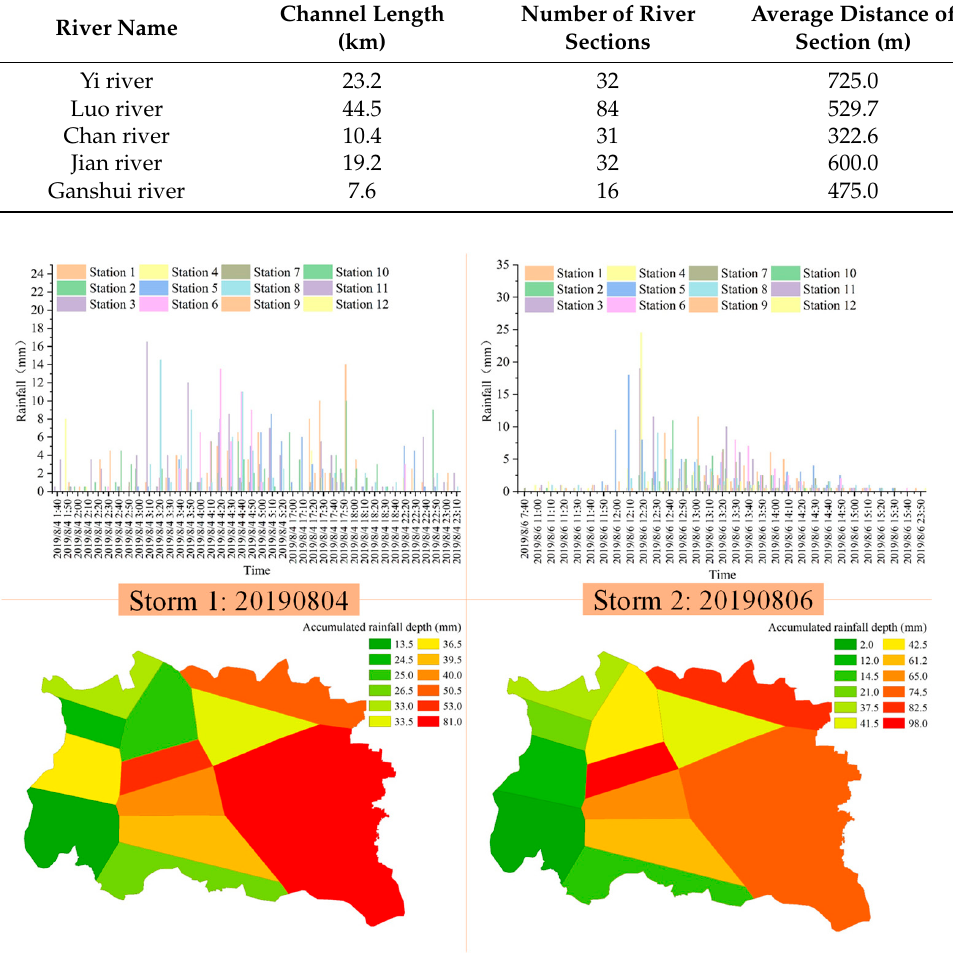
Figure 3. Hydrographs of the two historical rainstorms (4 August 2019 and 6 August 2019). Storm 1 started at 1:40 and ended at 23:10 on 4 August 2019. It was a unimodal rainstorm, the first rainfall peak occurring at 3:10 with an intensity of 16.5 mm/h and the second rainfall peak occurring at 17:30 with an intensity of 5.5 mm/h. Storm 2 started at 7:40 and ended at 23:50, lasting about 22 h on 6 August 2019, with a maximum intensity of 24.0 mm/h occurring at 12:20. Figure 3 shows the hydrographs of the storms.